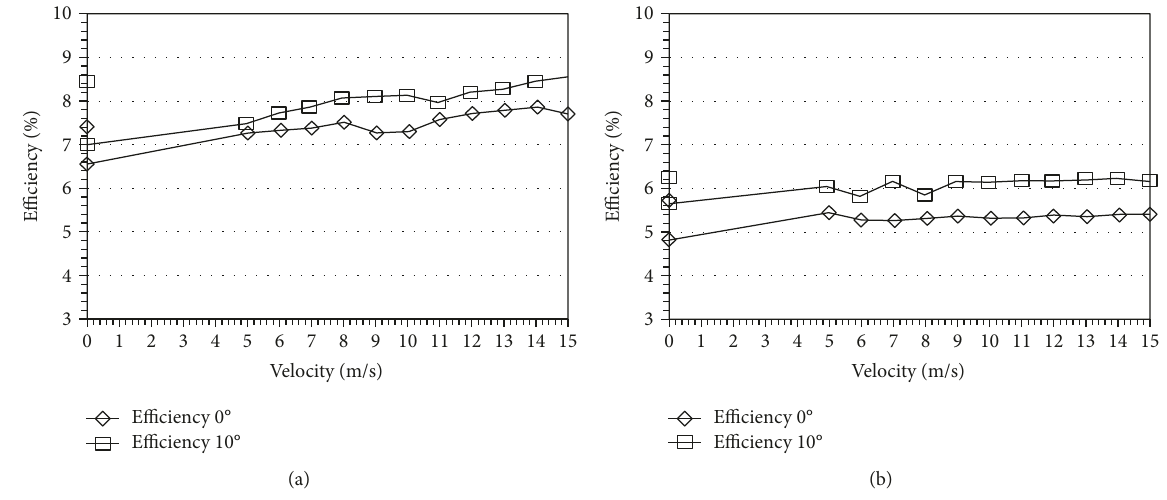
Figure 8: Modules e ffi ciency at di ff erent velocities. (a) Monocrystalline and (b)